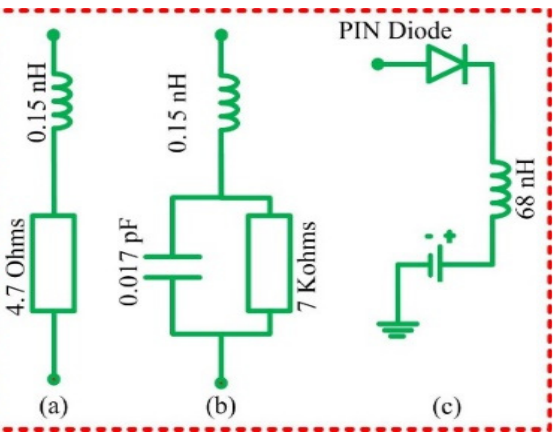
Figure 6. Equivalent circuit model of the ( a ) diode in the on ‐ state, ( b ) diode in the off ‐ state, and ( c ) biasing circuit to trigger the state of the diodes.